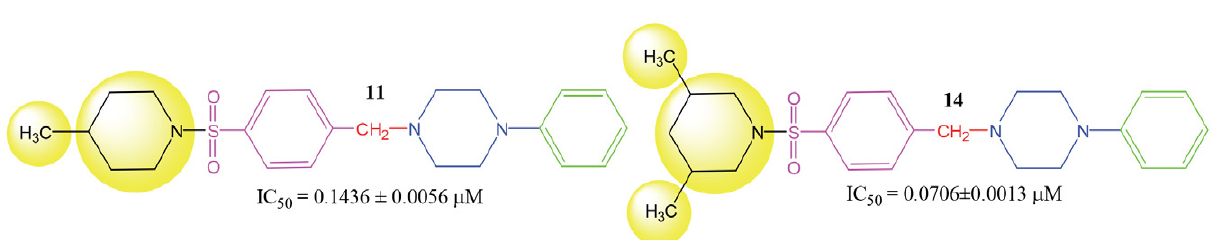
Figure 2. Structure-activity relationship of compounds 5 and 8 .